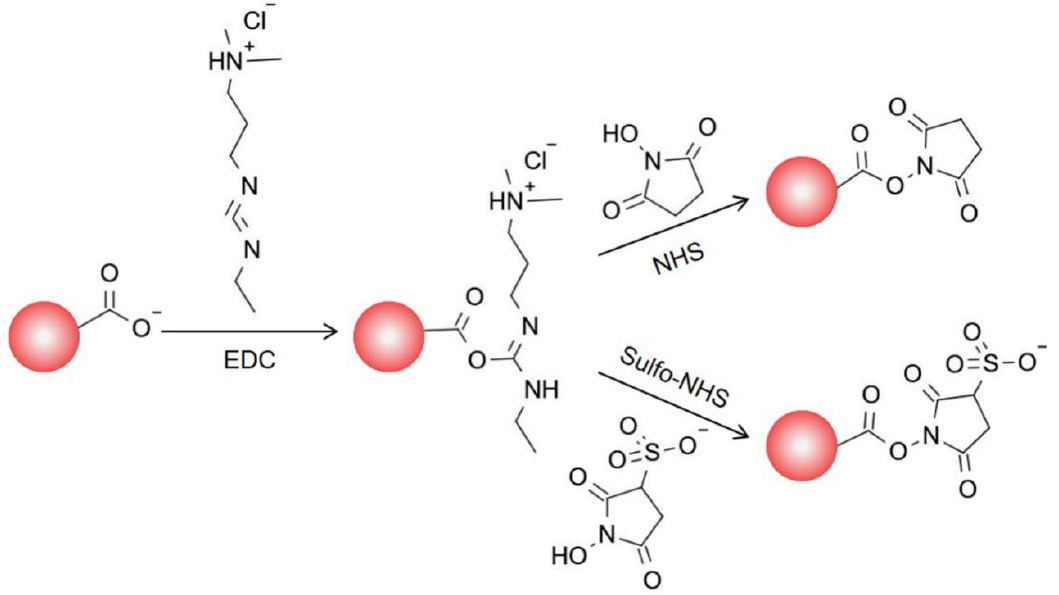
Figure 1. Scheme of activation mechanism of carboxyl MBs based on NHS/EDC chemistry.